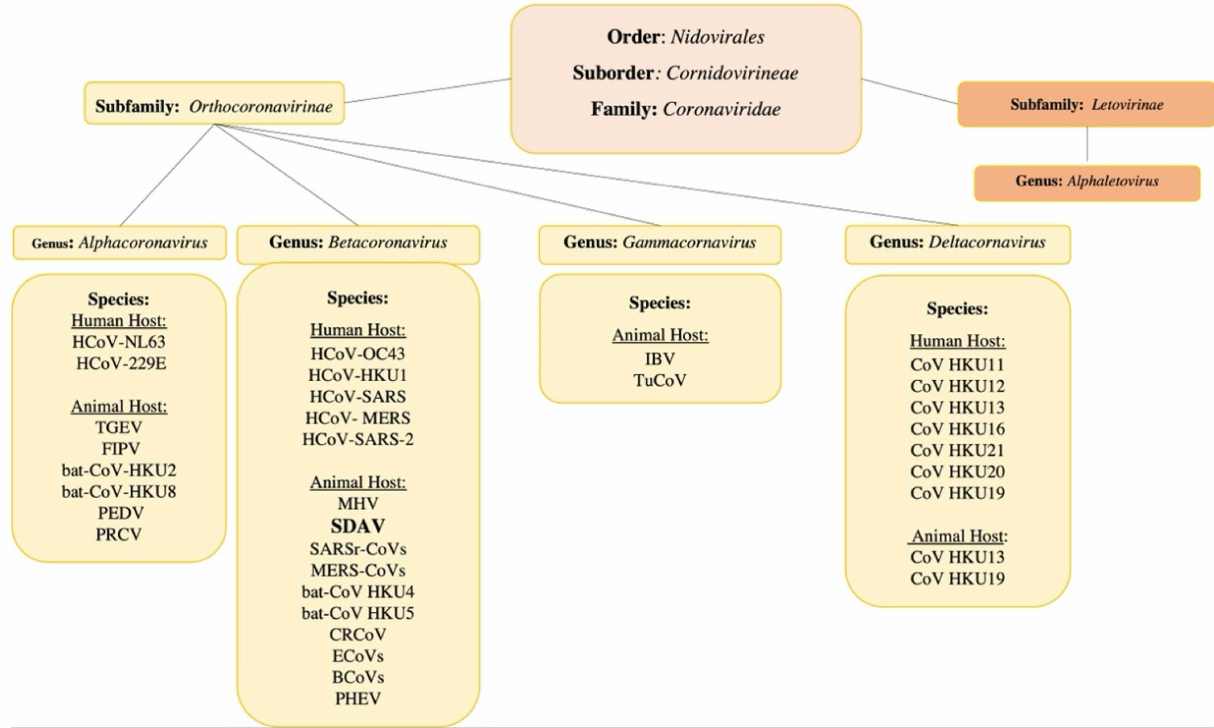
Figure 1. Taxonomy graph of the Coronaviridae family. Own work based on ICTV 2020 [36]. Abbreviations: alpha- coronaviruses: HCoV-NL63 (human coronavirus NL63), HCoV-229E (human coronavirus 229E), TGEV (transmissible gastroenteritis coronavirus), FIPV (feline infectious peritonitis virus), bat-CoV-HKU2 (Rhinolophus bat coronavirus HKU2), bat-CoV-HKU8 (Rhinolophus bat coronavirus HKU8), PEDV (porcine epidemic diarrheal virus), PRCV (porcine respiratory coronavirus); Betacoronaviruses: HCoV-OC43 (human coronavirus OC43), HCoV-HKU1 (human coronavirus HKU1), SARS (severe acute respiratory syndrome coronavirus), MERS (Middle East respiratory syndrome coronavirus), SARS-CoV-2 (Severe acute respiratory syndrome coronavirus -2), MHV (mouse hepatitis virus), SDAV (sialodacryoadenitis virus), bat-CoV- HKU4 (Tylonycteris bat coronavirus HKU4), bat-CoV-HKU5 (Pipistrellus bat coronavirus HKU5), CRCoV (canine respiratory coronaviruses), ECoVs (equine coronaviruses), BCoVs (bovine coronaviruses), PHEV (porcine haemaggluti- nating encephalomyelitis virus); Gammacoronaviruses: IBV (infectious bronchitis virus), TuCoV (turkey coronaviruses); Deltacoronaviruses: CoV HKU11 (bulbul CoV HKU11), CoV HKU12 (thrush CoV HKU12), CoV HKU 13 (munia CoV HKU13), CoV HKU16 (white-eye CoV HKU16), CoV HKU19 (night heron CoV HKU19), CoV HKU20 (wigeon CoV HKU20), CoV HKU21 (moorhen CoV